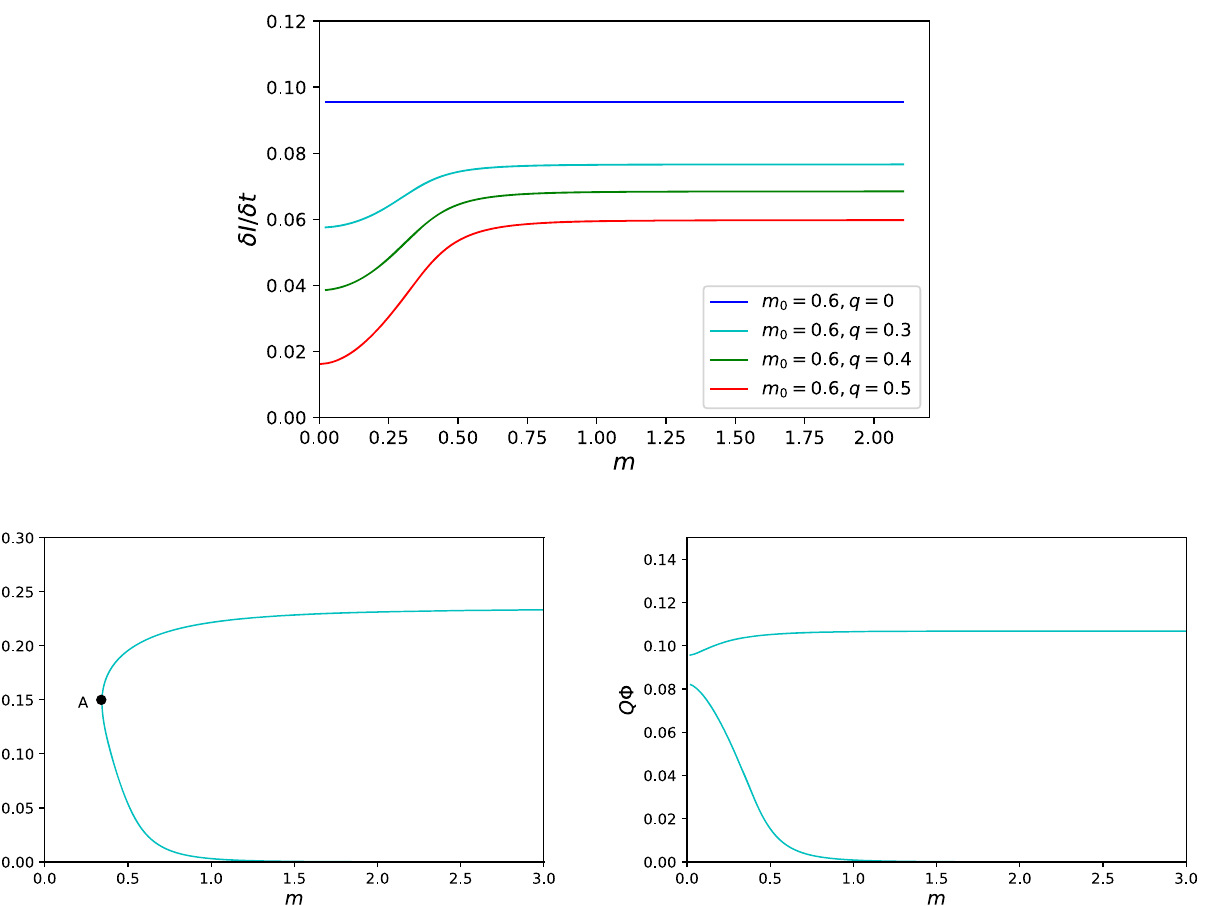
Fig. 2 The upper plot shows δ I δ the lower line is action growth rate. The mass and electric charge versus m for black hole with sin- t parameters are fixed as m 0 = 0 . 6 , q = 1 . 5 (lower left plot) or gle horizon. The parameters are fixed as m 0 = 0 . 6 ,(cid:3) = − 1 ,β = m 0 = 0 . 95 , q = 0 . 8 (lower right plot), other parameters are fixed 0 . 2 , d = 6 , k = 1 , c 1 = c 2 = c 3 = c 4 = − 1 . 5. The lower two plots shows Q (cid:8) versus m for black holes with inner and outer as (cid:3) = − 1 ,β = 0 . 2 , d = 6 , k = 1 , c 1 = c 2 = c 3 = c 4 = − 1 . horizons. For a fixed m , the difference between the upper line and